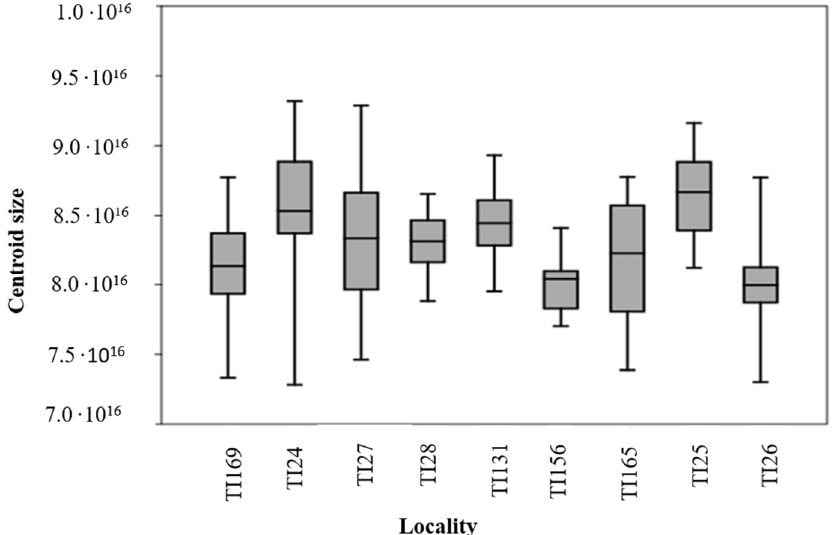
Figure 3. Box diagram of the centroid size of T. infestans populations from different localities: TI24 (Guarani das Missões/RS/BR); TI25 (Argentina/Cordoba); TI26 (Argentina/Sta. Fe); TI27 (Entre Ijuís/RS/BR); TI28 (Sto. Cristo/RS/BR); TI131 (Sta. Rosa/RS/BR); TI156 (Sta. Rosa/residual foci/RS/BR); TI165 (Cochabamba/Bolívia); TI169 (Tremedal/Residual foci/BA).